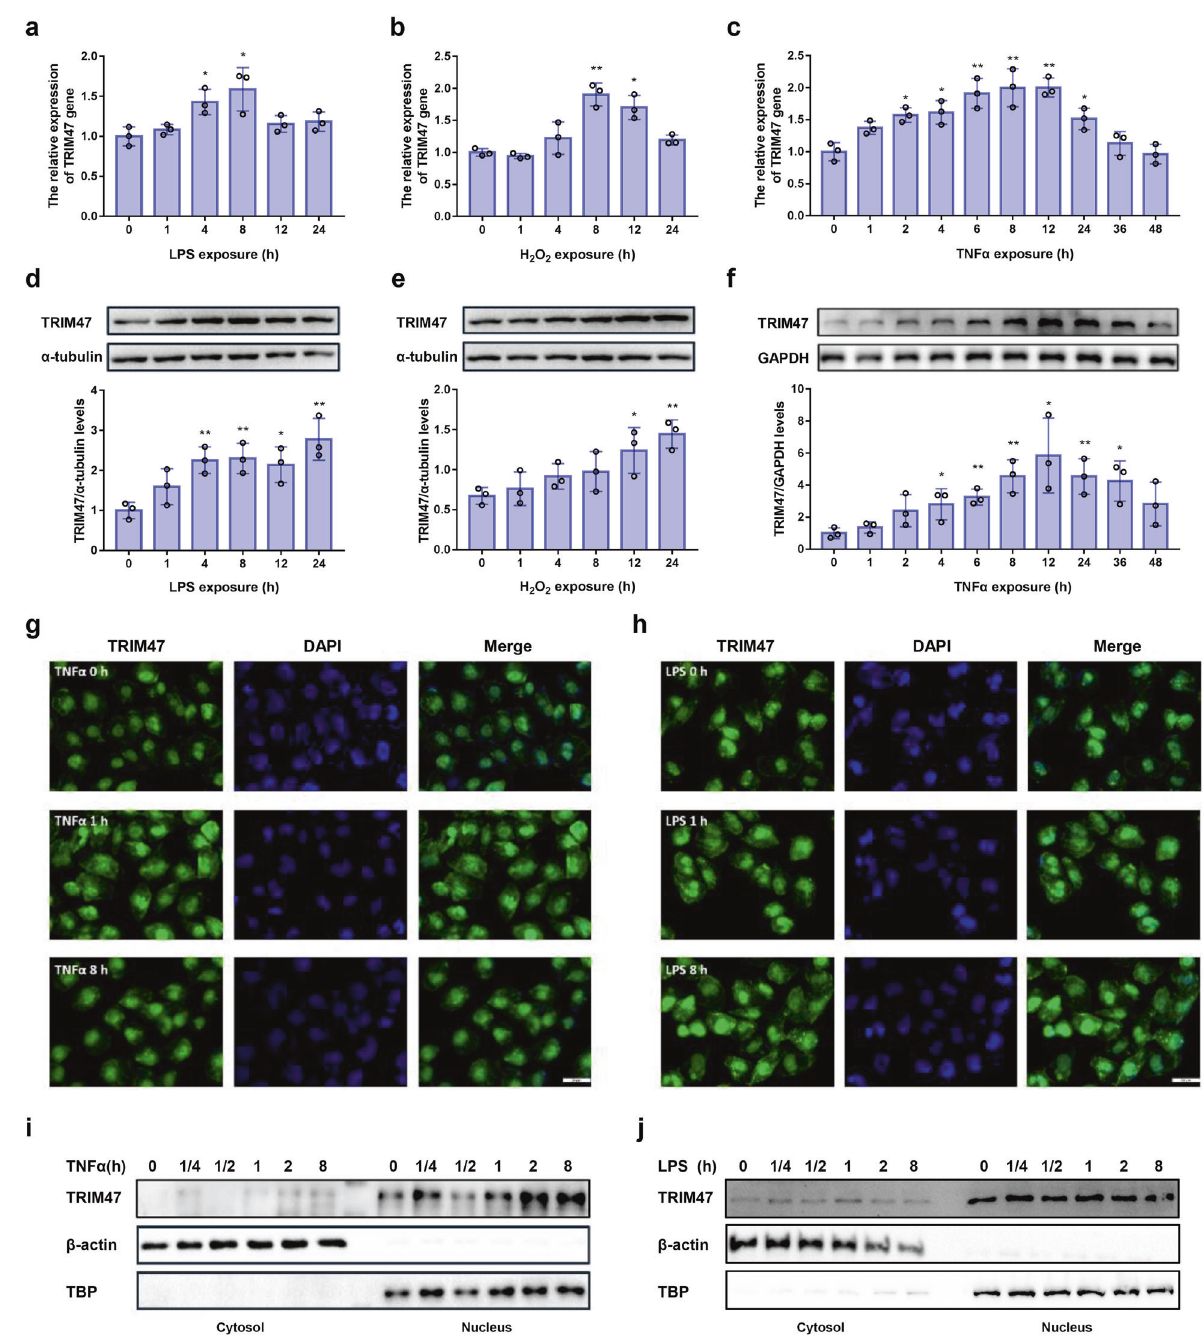
Fig. 4 TRIM47 is induced by in fl ammatory stimulation in HUVECs. The expression of TRIM47 in HUVECs after ( a ) LPS, ( b ) H 2 O 2 , and ( c ) TNF α stimulation was examined by real-time PCR ( n = 3, one-way ANOVA, * P < 0.05, ** P < 0.01 compared with the 0 h group). Representative images of the immunoblots of TIRM47, α -tubulin and GAPDH in HUVECs after ( d ) LPS, ( e ) H 2 O 2 , and ( f ) TNF α stimulation detected by western blot (up) and the relative quantitation of TIRM47 protein levels (down, n = 3, one-way ANOVA, * P < 0.05, ** P < 0.01 compared with the 0 h group). Representative images of the distribution of TRIM47 in HUVECs detected by immunocytochemistry after ( g ) TNF α and ( h ) LPS stimulation ( n = 3). Representative images of the cytosolic and nuclear location of TRIM47 following ( i ) TNF α and ( j ) LPS treatment measured by western blot in cytosolic and nuclear fractions ( n = TRIM47 activates NF- κ B and MAPK pro-in fl ammatory signaling pathways The potential signaling pathways including NF- κ B and MAPK in TRIM47-mediated endothelial activation were investigated. The results showed that knockdown of TRIM47 signi fi cantly inhibited the phosphorylation of I κ B α , IKK α / β , and p65 subunit, and